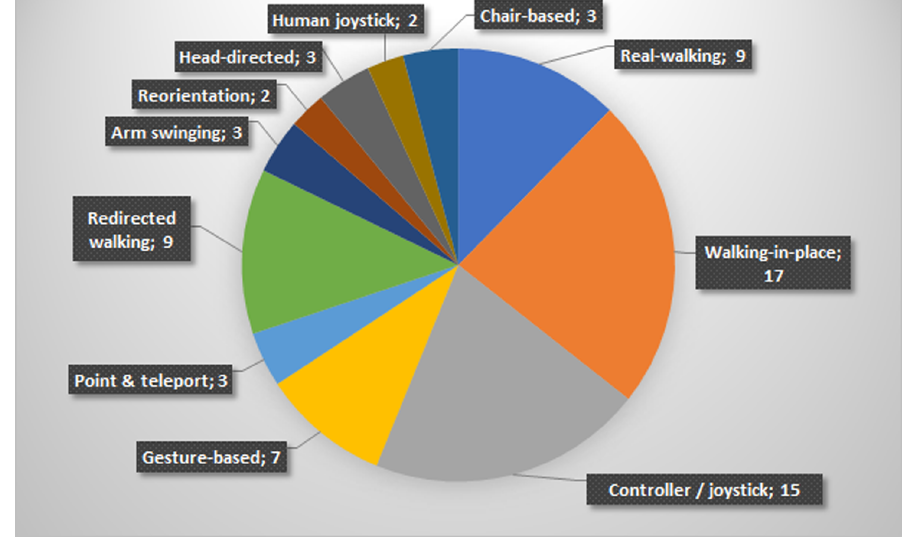
Figure 2. The 11 locomotion techniques and their number of instances, as documented from the 36 reviewed